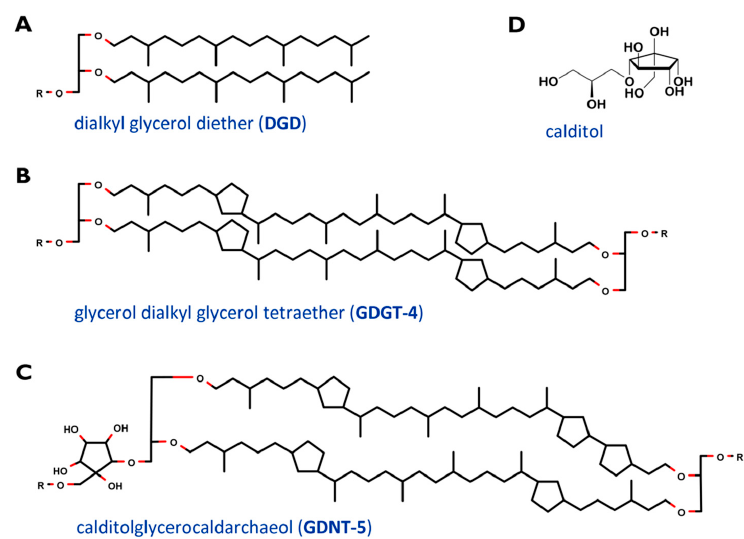
Figure 2. Core structure of major membrane lipids in Sulfolobus spp. ( A ) dialkyl glycerol diether (DGD); ( B ) glycerol dialkyl glycerol tetraether (GDGT); ( C ) glycerol dialkylnonitol tetraether (GDNT). R stands for polar head groups like (poly-) hexoses (Hex), inositolphosphate (IP), sulfonated trihexose (sulfono-Hex3), or can simply represent a single H- atom. The tetraether core structures are exemplarily depicted with 4 (GDGT-4) and 5 (GDNT-5) cyclopentane rings. ( D ) revised structure of the head group calditol, according to [35]. Table 1. Overview membrane lipid composition of Sulfolobales , Natronococcus and Methanobacterium . Membrane